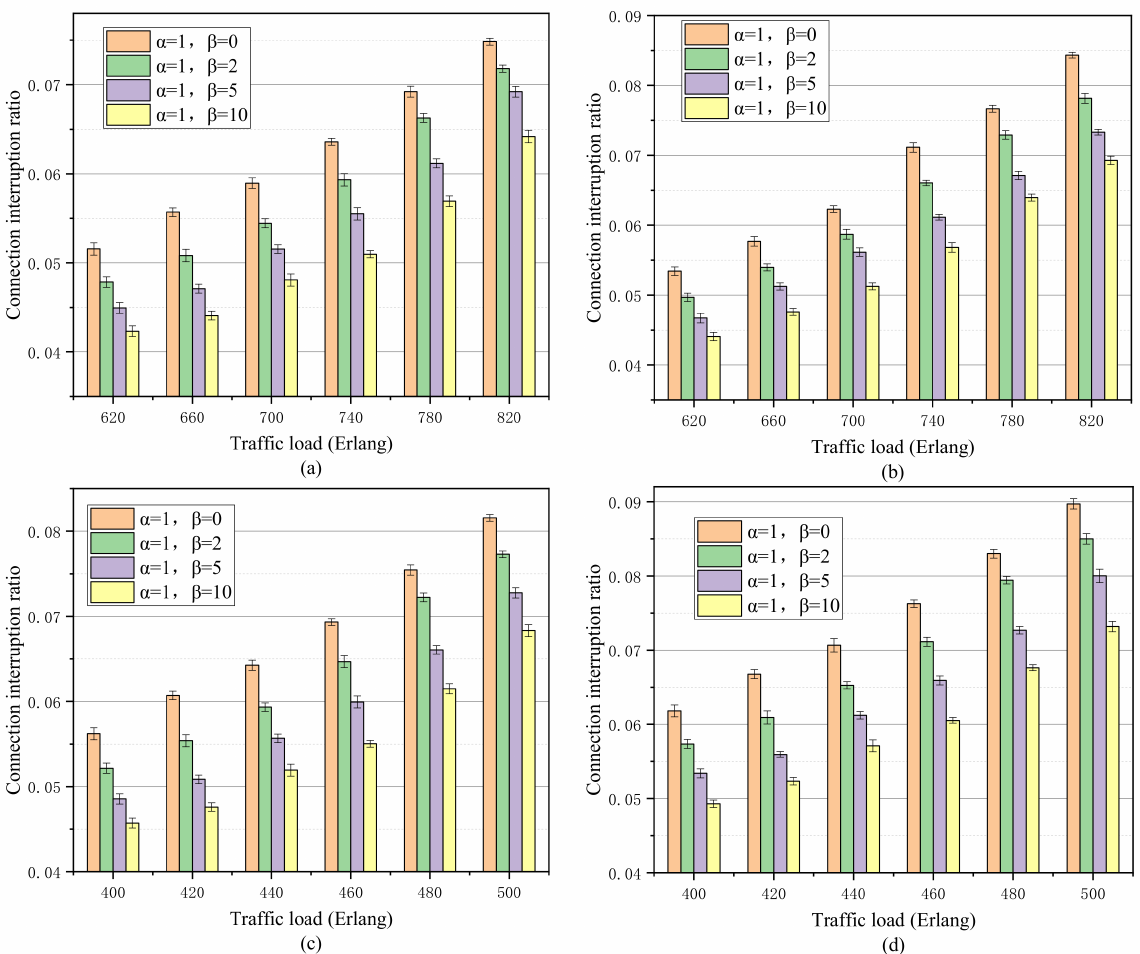
Figure 7. ( a ) CIR under uniform traffic model when 16 nodes are upgraded in USNET; ( b ) CIR under non-uniform traffic model when 16 nodes are upgraded in USNET; ( c ) CIR under uniform traffic model when 10 nodes are upgraded in NSFNET; ( d ) CIR under non-uniform traffic model when 10 nodes are upgraded in